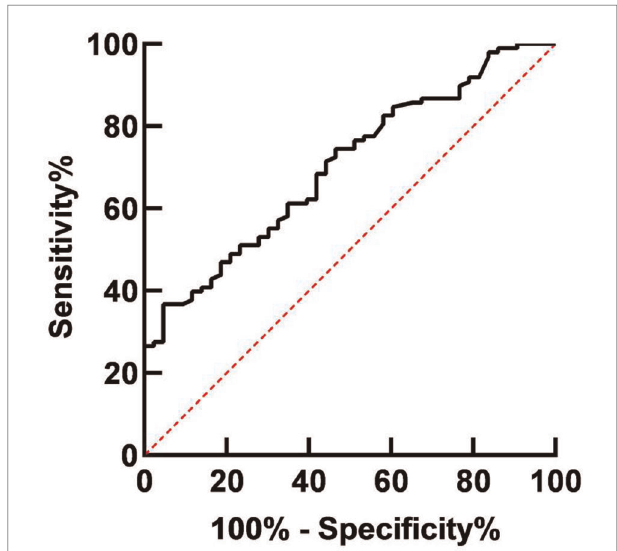
FIGURE 1 | Expression of miR-4739 in GC tissue and paracancerous tissue. Note: Compared with gastric cancer tissue, * P <0.05.